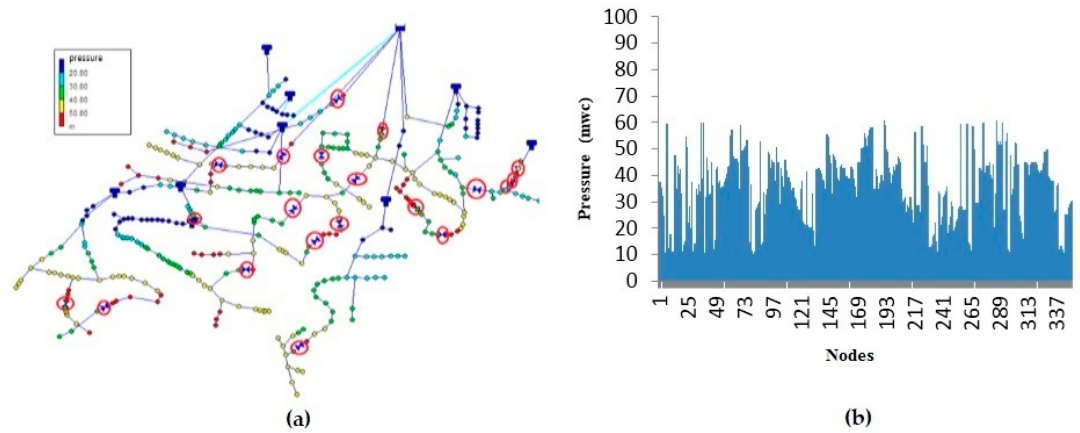
Figure 4. Pressures for each node after adding new tanks and PRVs (feasible solution). ( a ) New PRVs added ( b ) Pressure distribution.